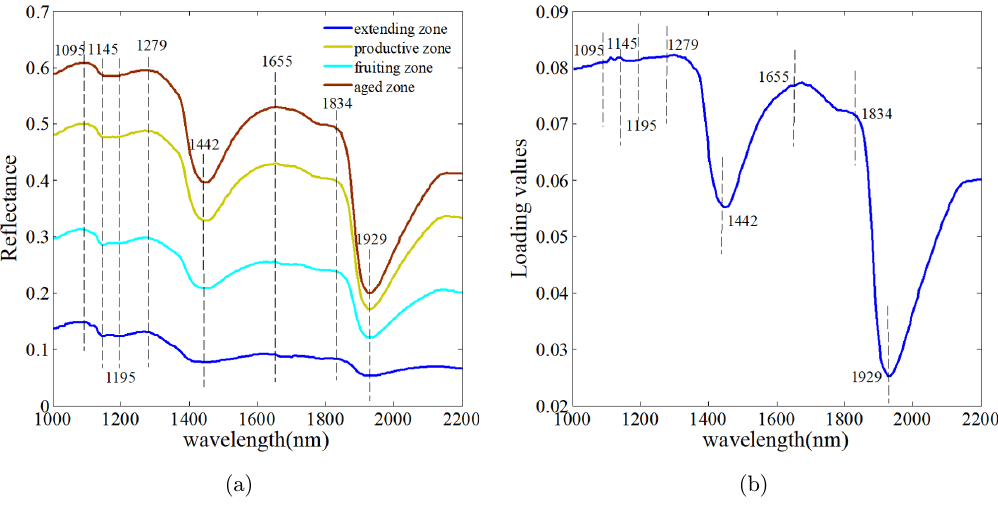
Fig. 6. Characteristic wavelengths selection. (a) Average spectra of each zone. (b) Loading plot of PC 1